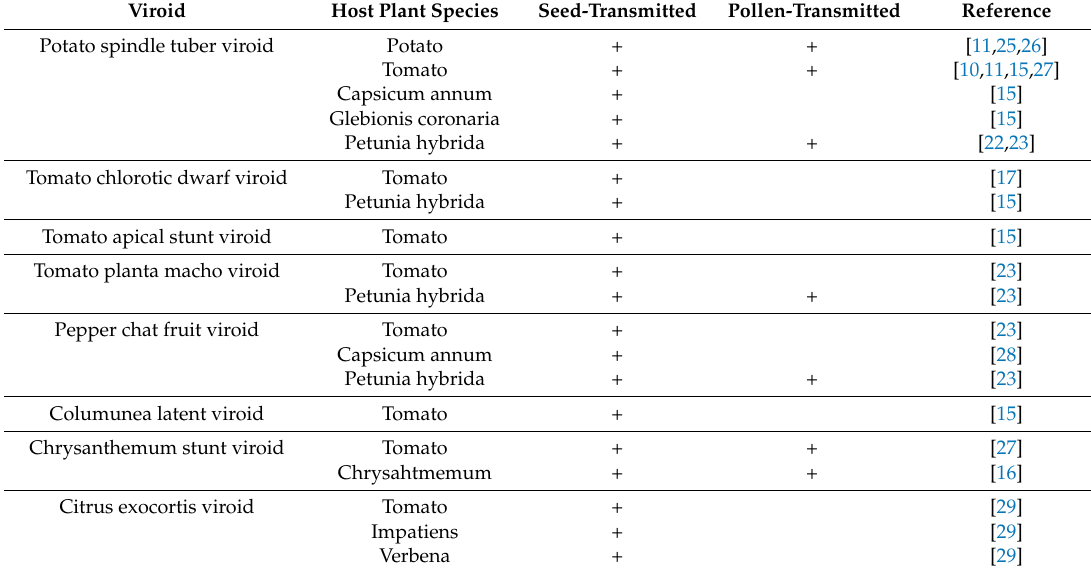
Table 1. Seed- and pollen-transmitted